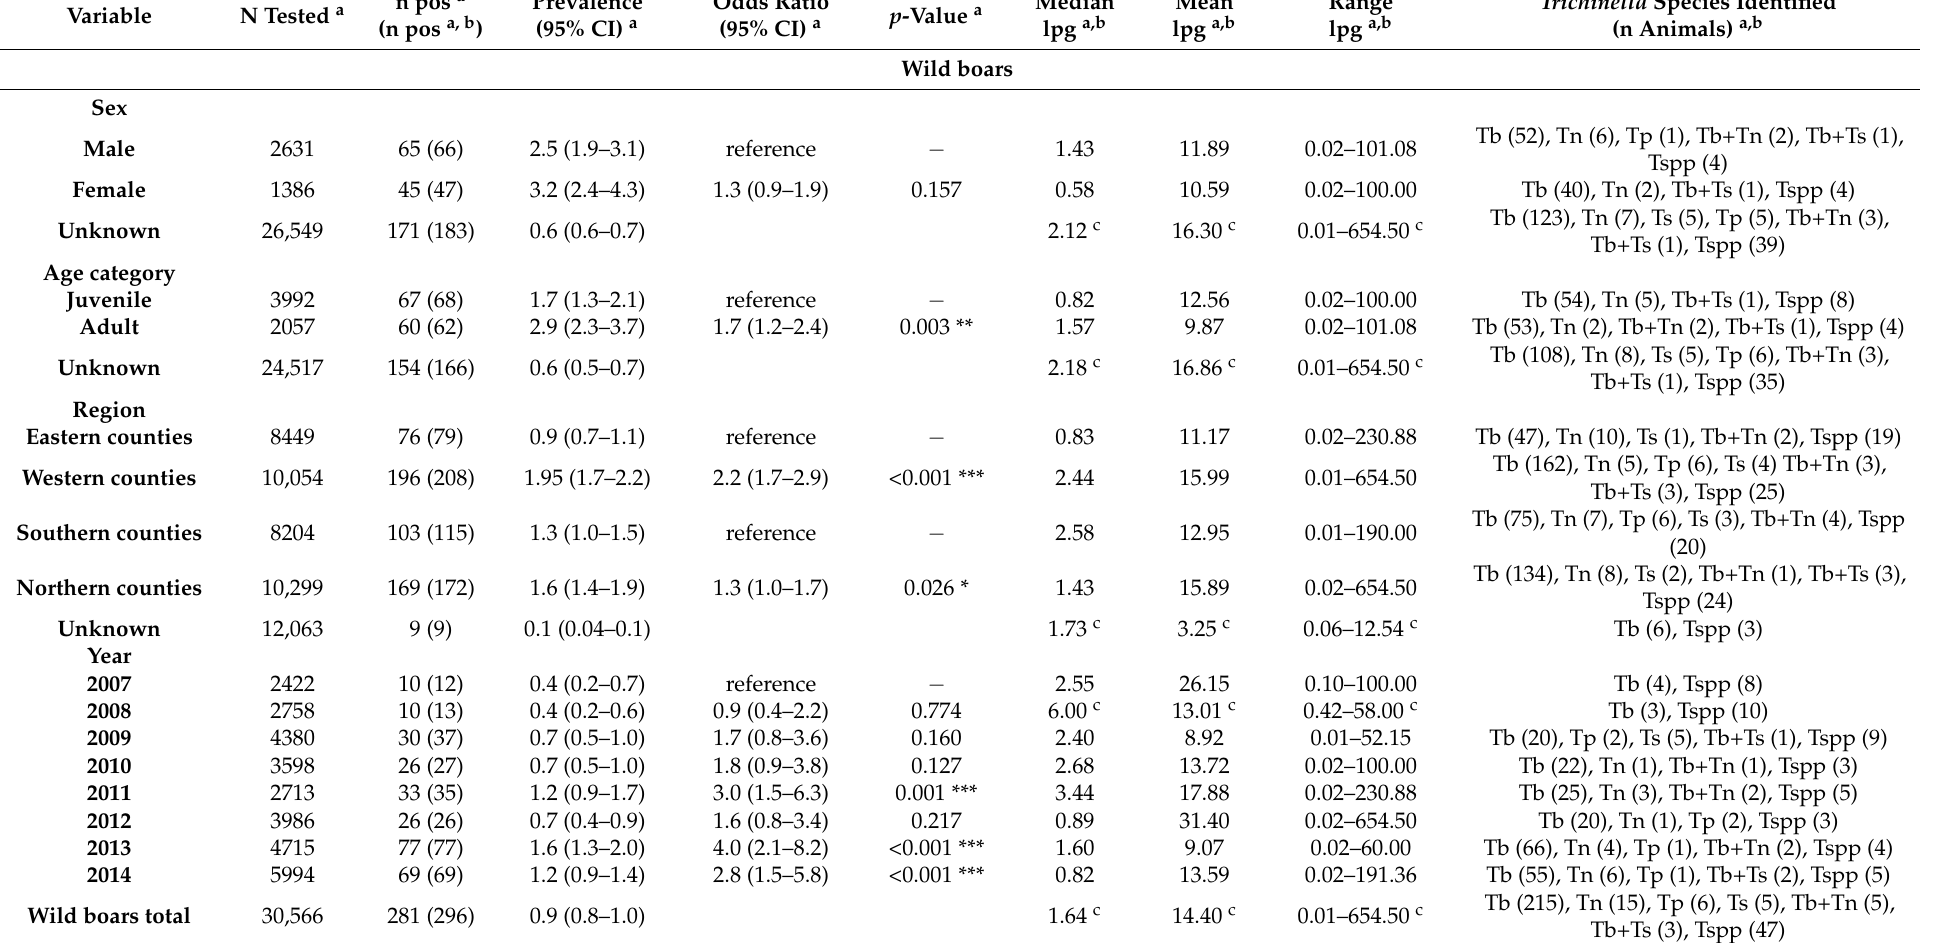
Table 1. Prevalence of Trichinella infection in wild boars ( Sus scrofa ), brown bears ( Ursus arctos ), Eurasian lynxes ( Lynx lynx ) and badgers ( Meles meles ) hunted in Estonia, 2007–2014, by sex, age category, region, and year. Univariable odds to test positive in comparison to the reference sex (male), age category (juvenile), east-west category (eastern counties), south-north category (southern counties), and year (2007) are shown for each variable, and larval burden data and the Trichinella species identified are